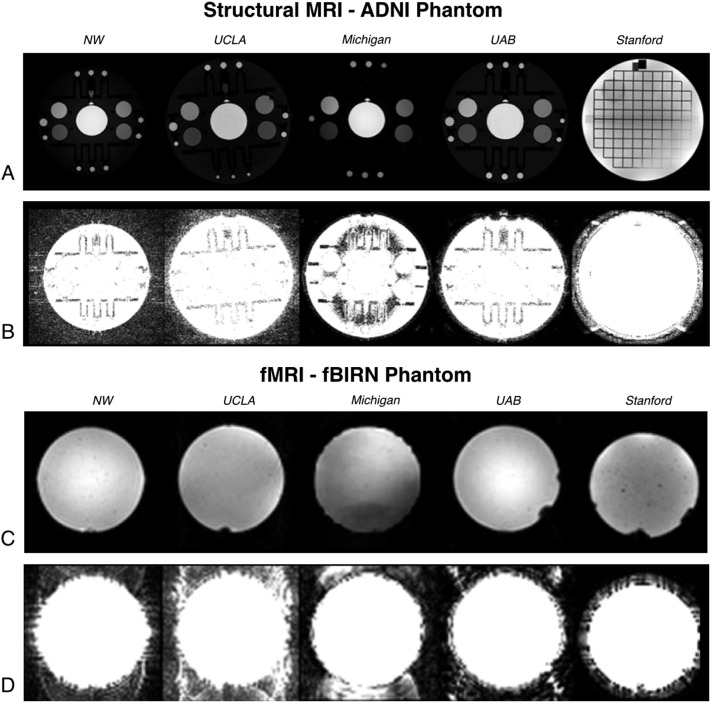
Structural and fMRI phantom results. A) Center slice from axial 3D T1-weighted (MPRAGE or IR-FSPGR) images from ADNI (or ACR) phantom (intensity autoscaled). B) Equivalent slices from (A) upscaled 100-fold to permit visualization of background noise and artifacts. C) Representative resting-state fMRI images of the fBIRN phantom (intensity autoscaled). D) Equivalent slices from (C) upscaled 100-fold to highlight background noise and artifacts.